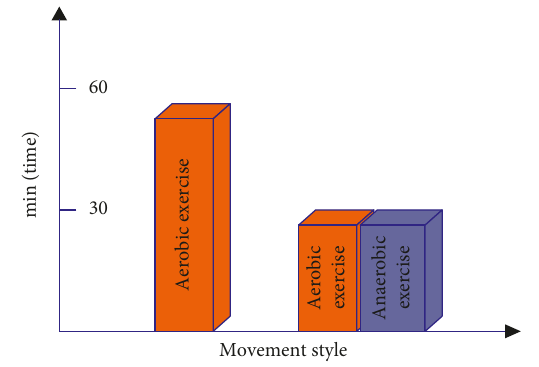
Figure 11: Movement time design. Table 3: Exercise program